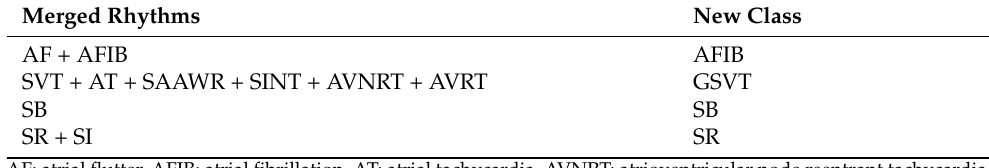
Table 1. Information on the merged ECG rhythm classes’ labels.